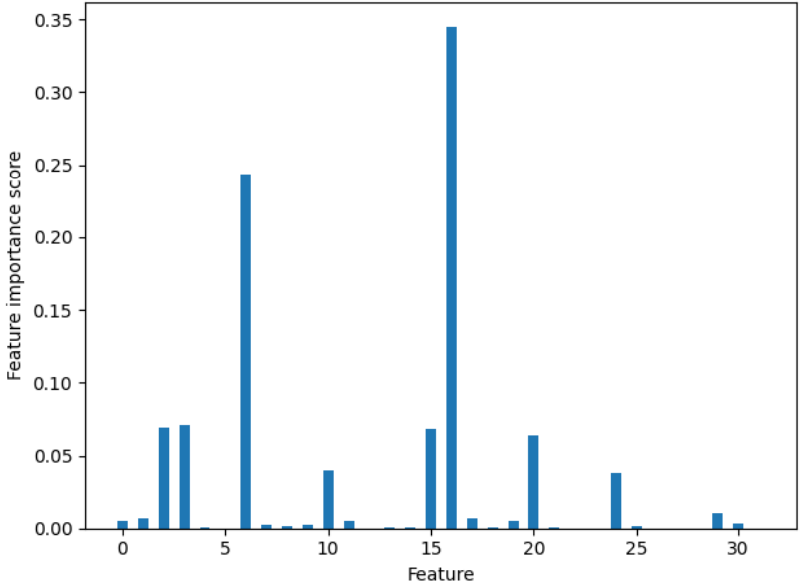
Figure 2. The features obtained by CNN are scored using random forest for importance (the latter 32 features are not shown because of low importance scores). X-axis represents the analyzed fea- tures, and Y-axis denotes the importance